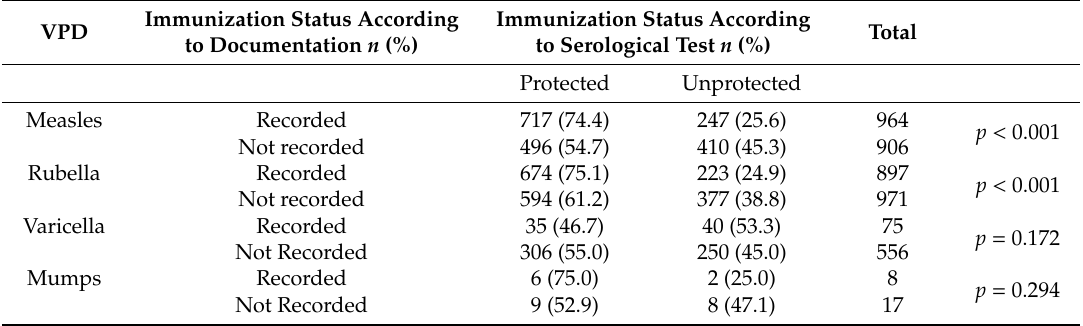
Table 4. Comparison between documentation recorded and serological tests performed in